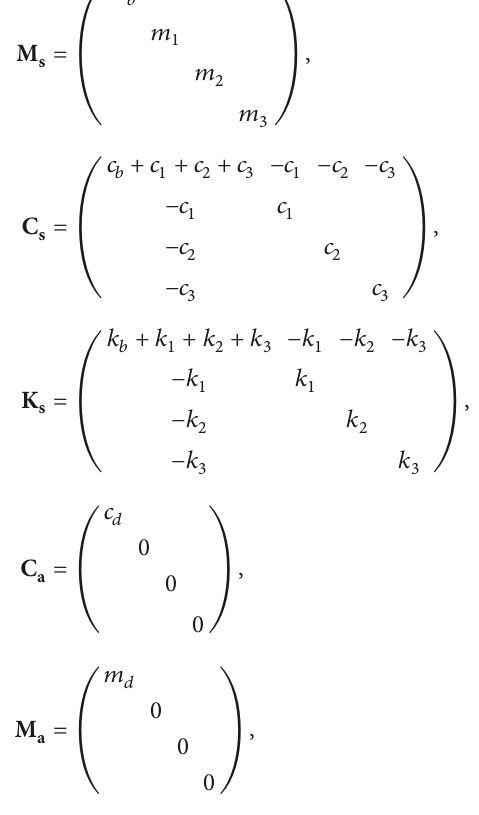
Two-terminal element